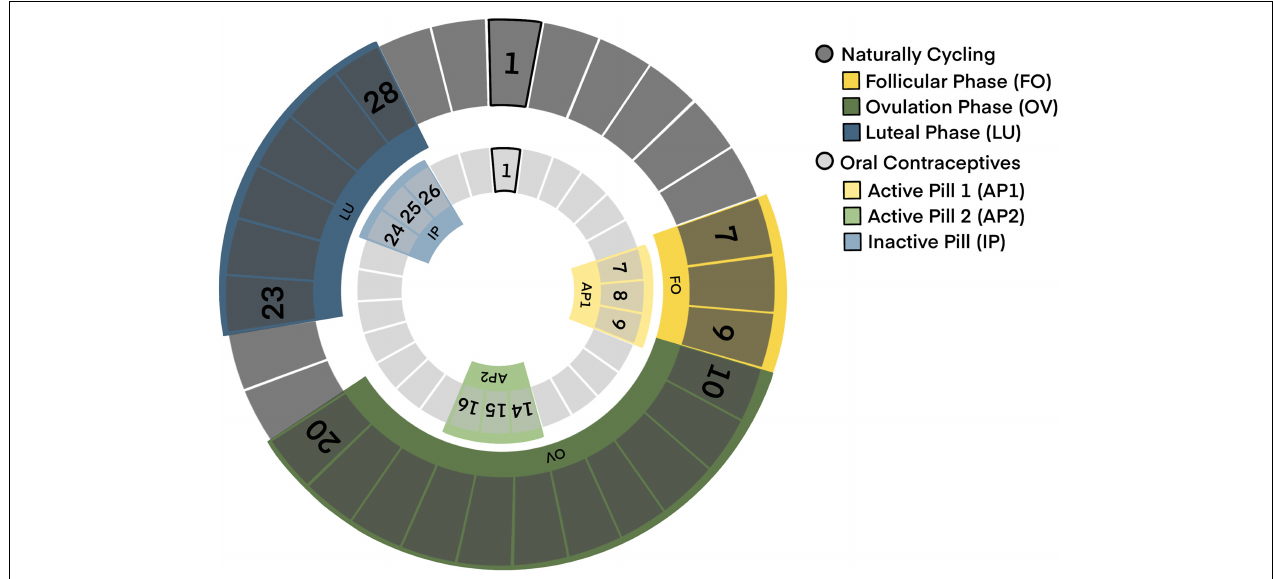
FIGURE 1 | Testing dates for naturally cycling and oral contraceptive using women.